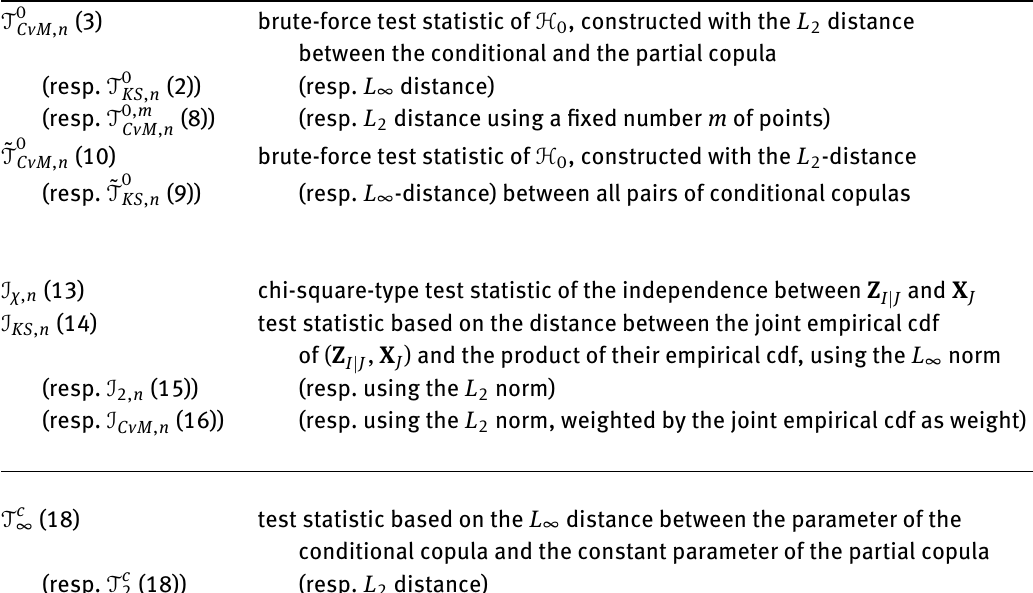
Table 6: Table of main test statistics T 0 CvM , n